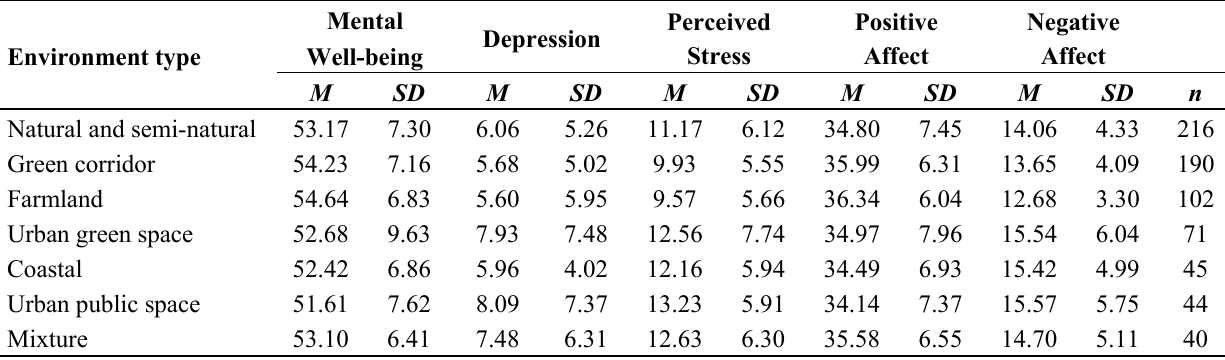
Table 4. Mean and standard deviation for mental well-being, depression, perceived stress, positive affect and negative affect of frequent WfH walkers within each environment type ( n =